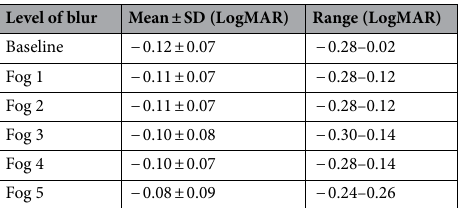
Table 2. Mean SD binocular photopic HCVA at baseline and at each level of